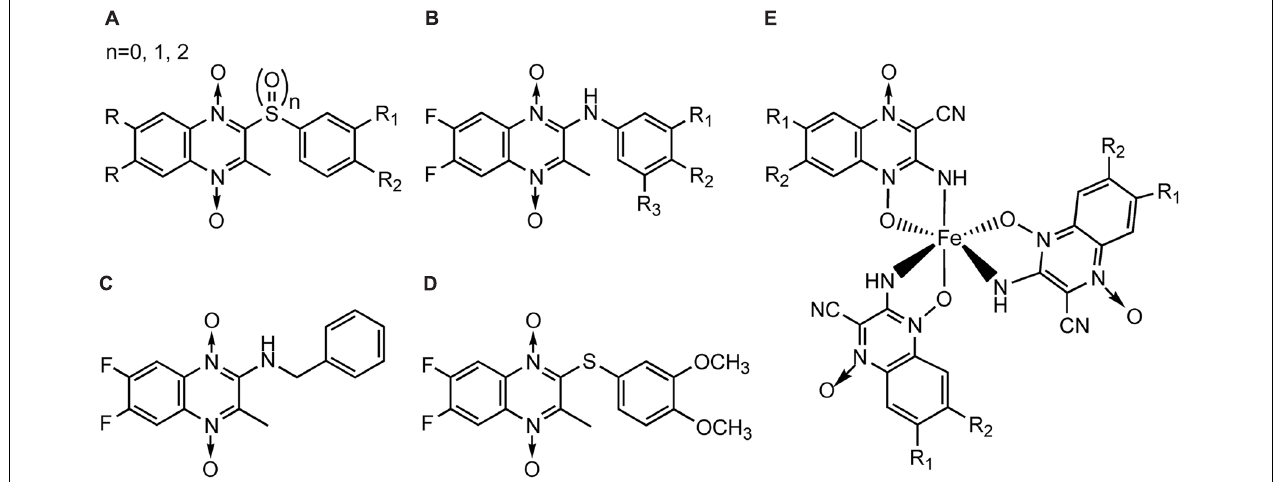
FIGURE 4 | General structures of QdNOs with antimycobacterial activity published by Zanetti’s (A–D) and Gambino’s teams (E).